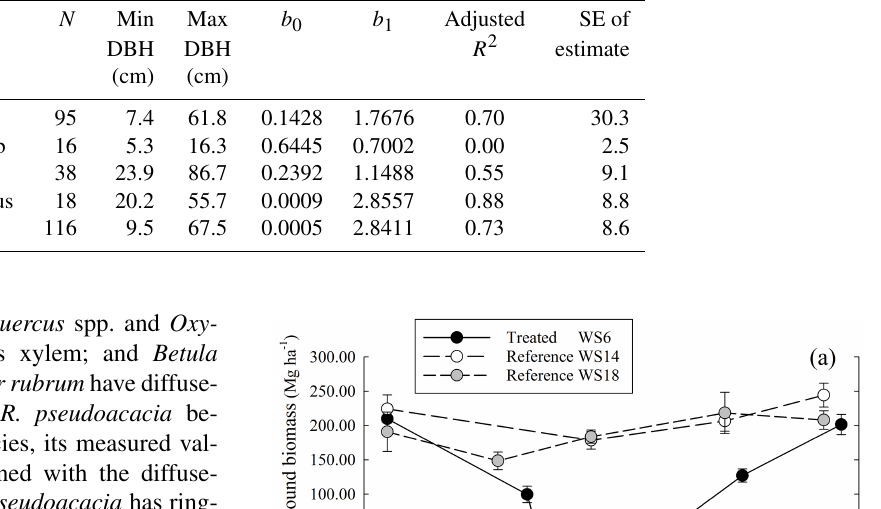
Table 2. Summary of growing-season daily water use (DWU, kgday − 1 ) models for each xylem functional group as a function of stem diameter at breast height (DBH, cm); DWU = b 0 · DBH b